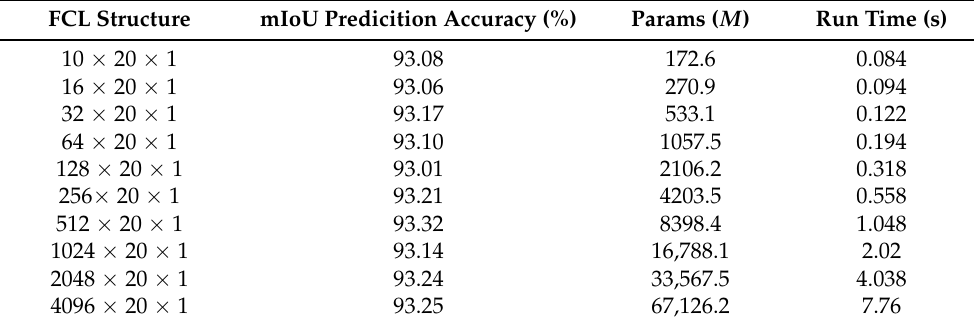
Table 4. Mean intersection of union (mIoU) prediction accuracy and run time of various fully connected layer (FCL)